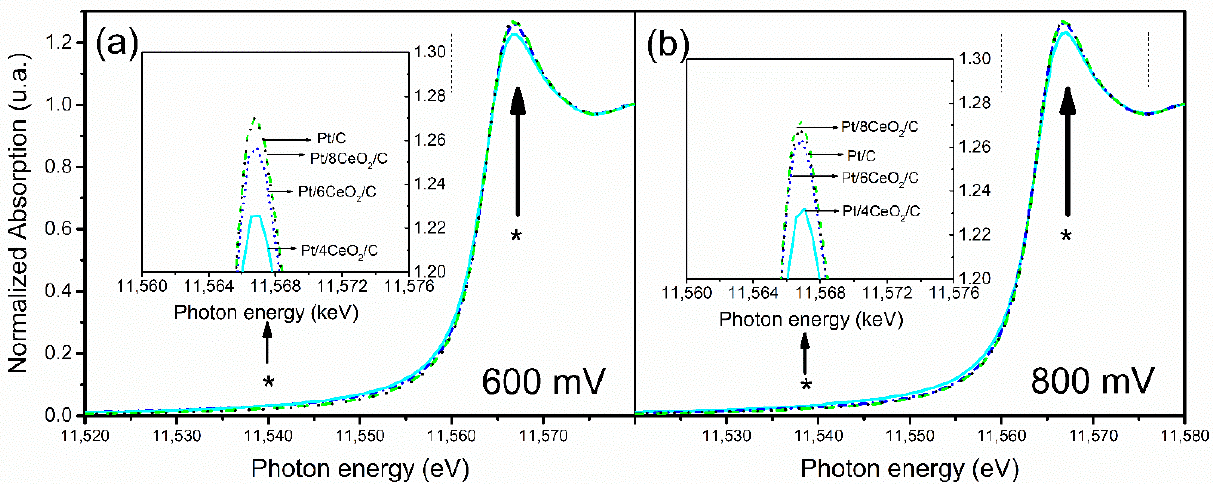
Figure 6. XANES Pt LIII absorption for Pt/C and Pt/CeO 2 /C catalysts in 0.1 mol L − 1 at 0.6 V ( a ) and 0.8 V ( b ) vs. RHE. Inset: white line magnitude in the range 11,560–11,576 eV.